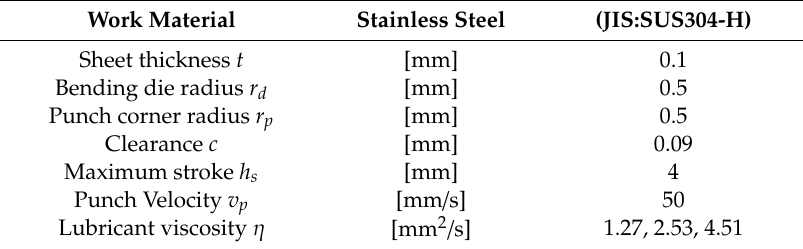
Table 2. Operation conditions of bending with the ironing